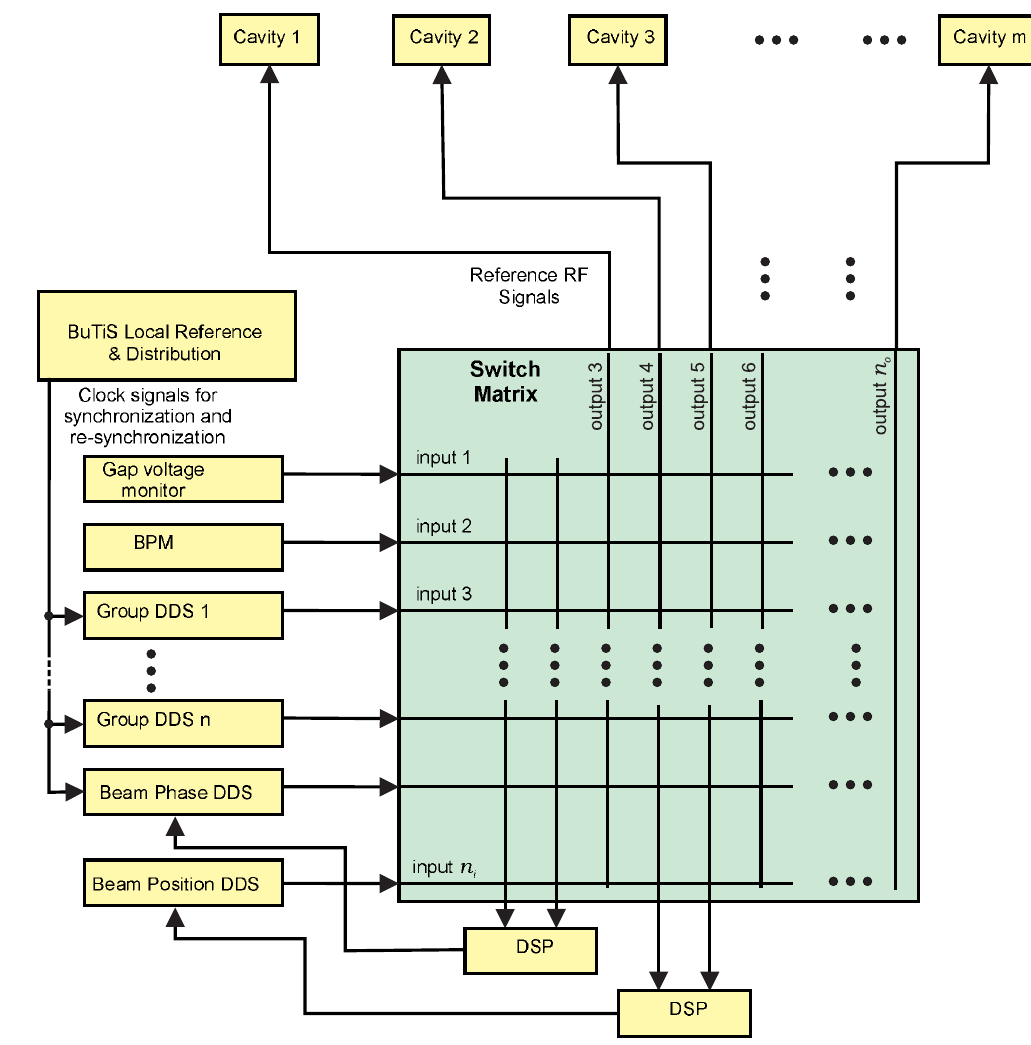
FIG. 1. Routing of group DDS signals to cavity